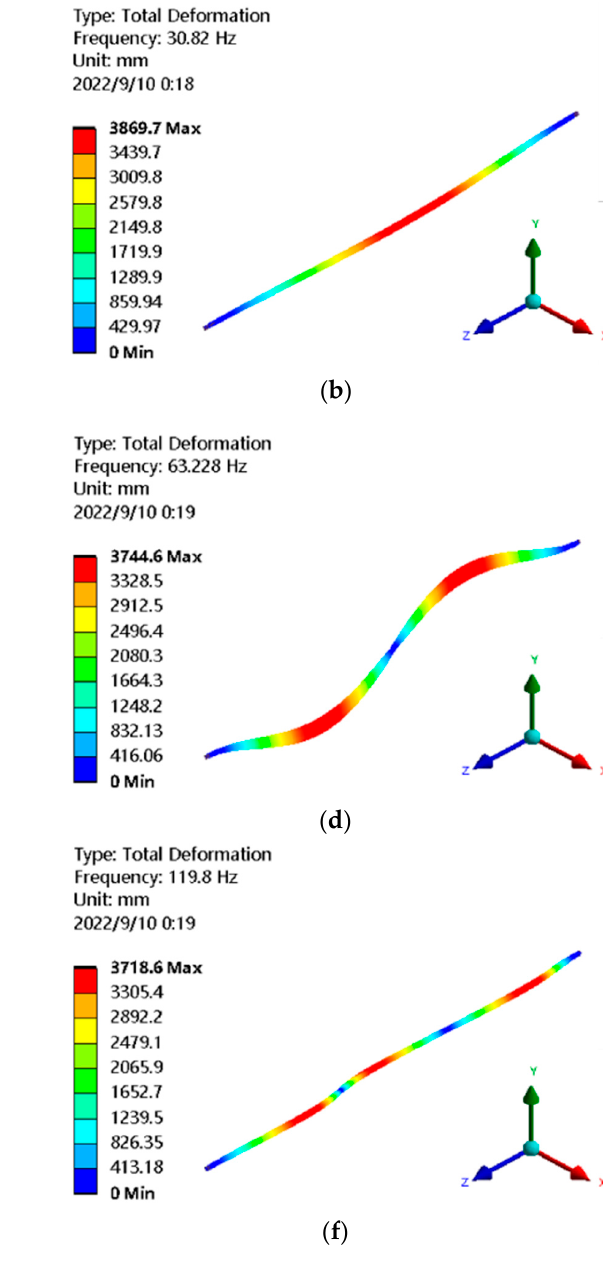
Figure 5. The first 6 modes of the fluid-structure interaction mode of hollow fiber membrane (length 200 mm, air velocity 3 m/s). ( a ) the first order; ( b ) the second order; ( c ); the third order; ( d ) the fourth order; ( e ) the fifth order; ( f ) the sixth order.